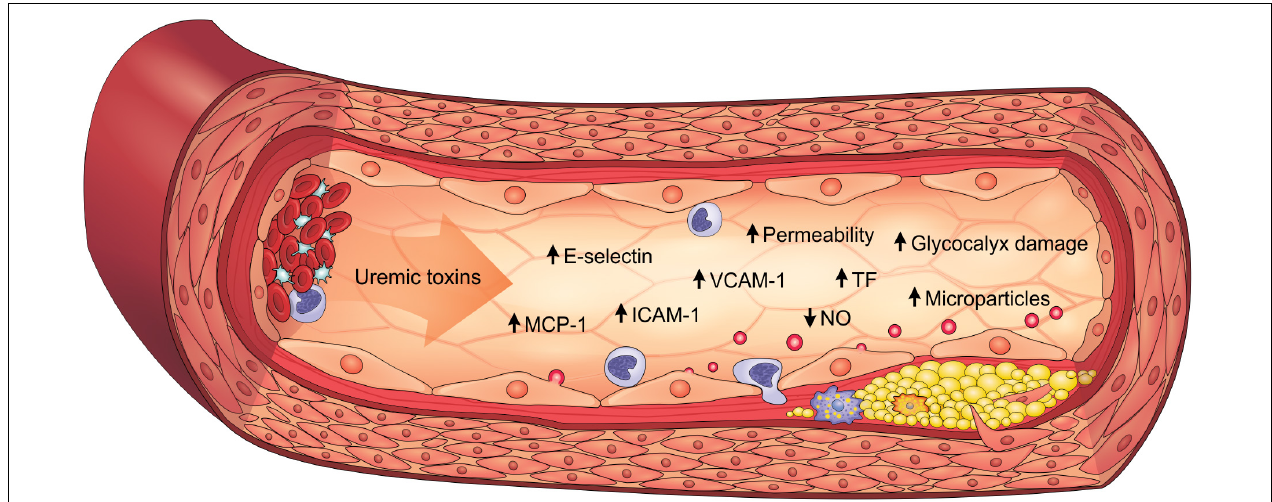
FIGURE 2 | Uremic toxicity is linked to endothelial dysfunction in CKD. Uremic toxins induce the expression of proinflammatory factors (e.g., MCP-1, E-selectin, ICAM-1, and VCAM-1), prothrombotic factors (e.g., TF), damage to the glycocalyx, the increase in permeability, the reduction of NO bioavailability and the formation of endothelial microparticles. As a result, endothelial dysfunction contributes to the pathogenesis of cardiovascular diseases, such as atherosclerosis. ICAM-1, intercellular adhesion molecule-1; MCP-1, monocyte chemoattractant protein-1; NO, nitric oxide; TF, tissue factor; VCAM-1, vascular cell adhesion